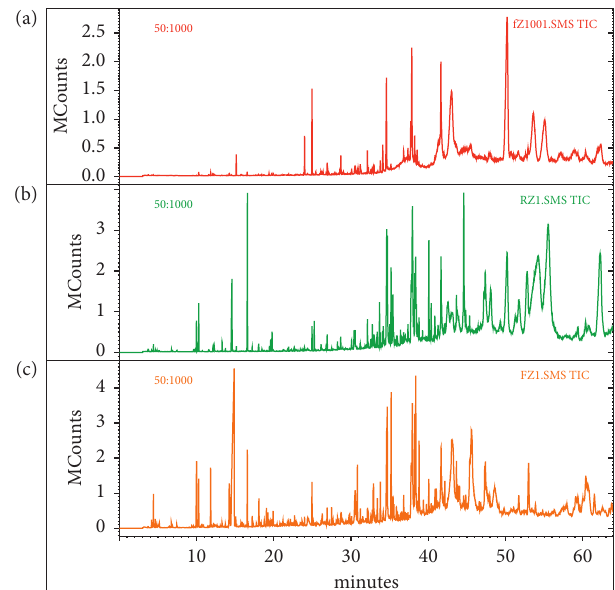
Figure 2: Representative GC–MS spectra of bioactive fractions from the flowers (F); the leaves (f) and the roots (R) of Lobularia maritima with retention time. (a): spectra from leaves bioactive fraction; (b): spectra from roots bioactive fraction and (c): spectra from flowers bioactive